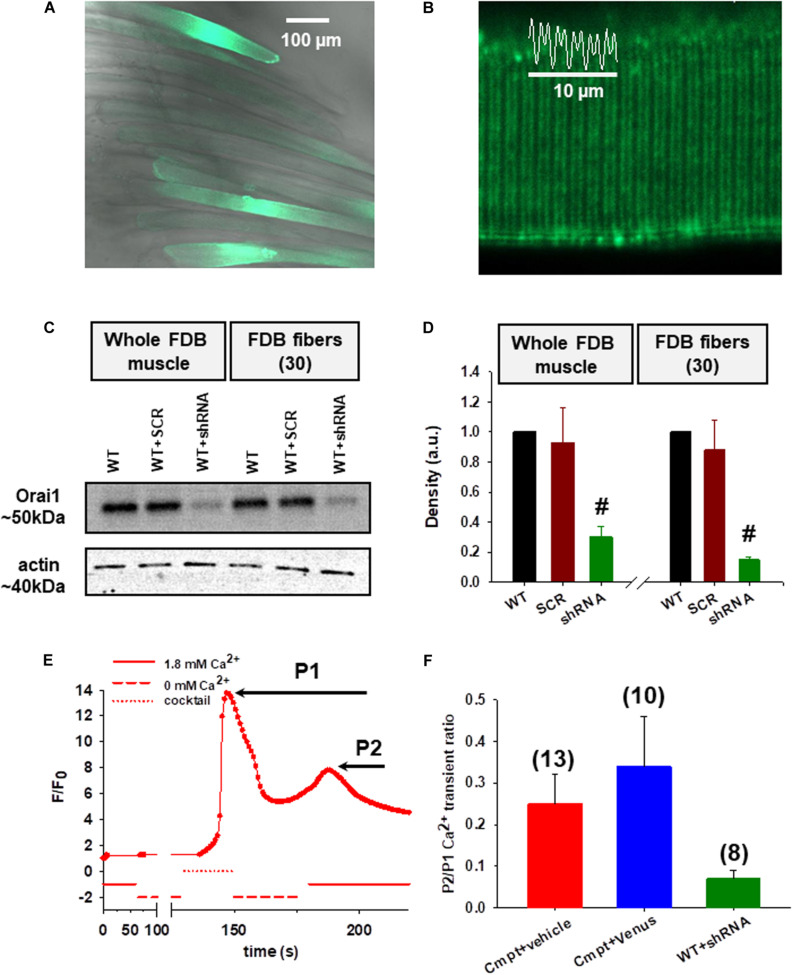
Functional consequences of Orai1 protein level manipulation by in vivo plasmid electroporation. (A) Good efficiency of venus-Orai1 expression in Cmpt mice where a high percentage of the muscle fibers were transfected as illustrated by them displaying bright fluorescence signals. (B) Representative image showing correct targeting of venus-Orai1 to the triad in Cmpt mice as highlighted by the double-banded pattern of venus’ fluorescence. The white trace illustrates the fluorescence intensity profile plotted as a function of distance along the white line for five successive triads. (C) Immunoblot analysis in WT mice 5-days after the small-hairpin RNA (shRNA) against Orai1 was introduced into FDB muscles using electroporation showed a significant reduction in the Orai1 protein levels. A scrambled non targeted shRNA probe was used as control along with samples collected from the untreated WT mice. The analysis was performed on whole FDB muscles and also using ∼30 individual FDB fibers identified via the GFP signal and manually collected using a fluorescence microscope. Actin was used as internal control. (D) Quantitative densitometry analysis of four independent immunoblots revealed a significant decrease of Orai1 levels compared to WT taken as 100% in both whole FDB muscles and single fibers, respectively (#p < 0.001) (E) A representative SOCE measurement showing the fluorescence profile versus elapsed time following various solution exchanges performed on a Cmpt fiber injected with physiological saline solution (vehicle) and stained with rhod-2 AM. WT FDB fibers were silenced with shRNA-Orai1 5 days before dissection. Following the removal of calcium from the external solution the application of a releasing cocktail (see Materials and Methods and also Sztretye et al., 2017) caused a rapid and robust increase in fluorescence (P1) due to Ca2+ release from the SR via RyR1s. After returning to the 1.8 mM Ca2+ concentration in the external solution, a slowly activated secondary increase in fluorescence was detected corresponding to the consequent SOCE activation (P2). (F) The ratios of the peak of the slow Ca2+ transient (P2), representing the activation of SOCE, and that of the depleting-cocktail induced fast SR Ca2+ transient (P1). The numbers in parentheses indicate the numbers of individual cells studied. Note that reconstructing the Cmpt fibers with Orai1 does not restore SOCE, but silencing Orai1 in WT fibers does impede proper SOCE function.